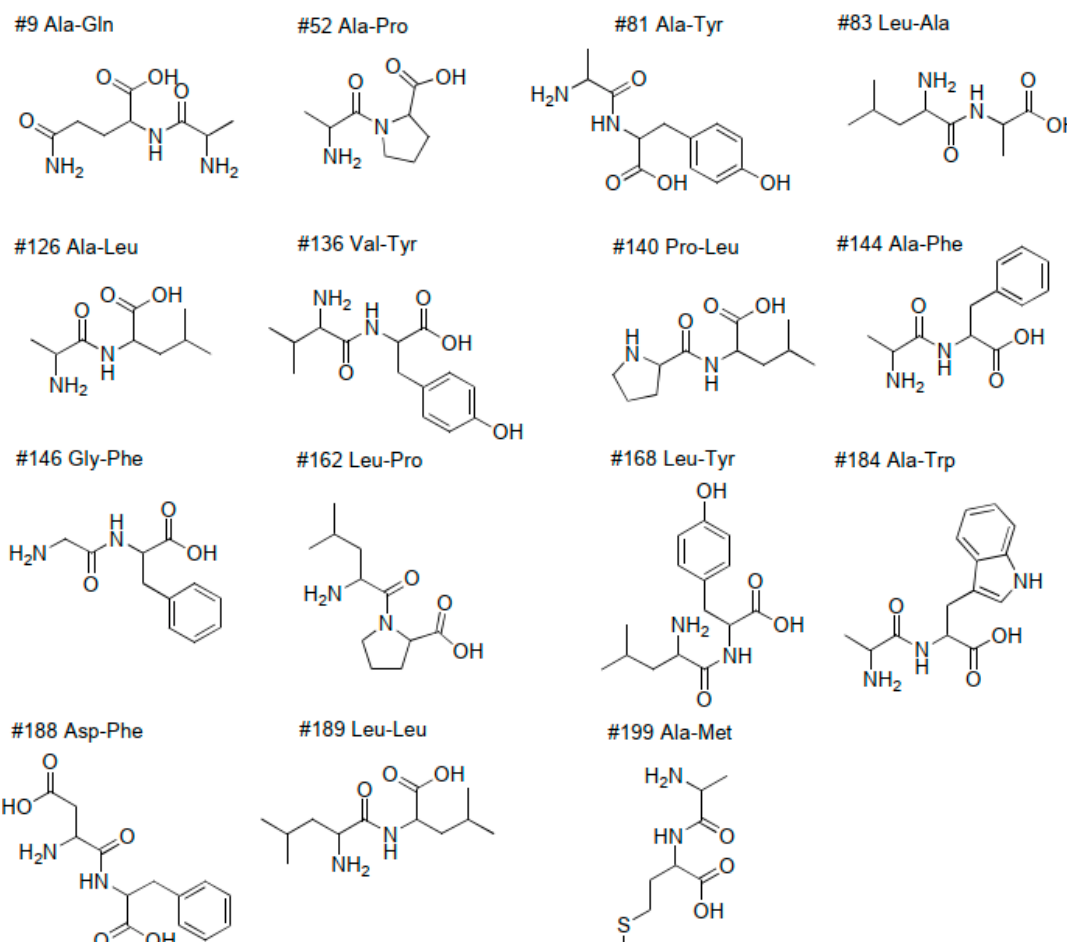
Figure 3. Dipeptides, whose presence was verified with authentic standards and #ID from Table 2.